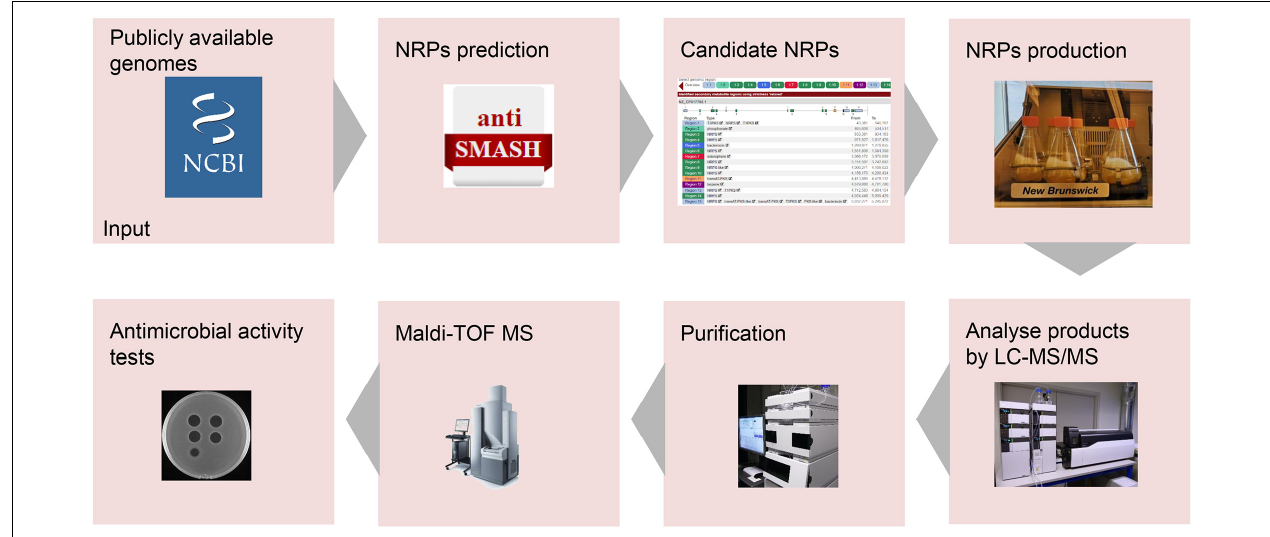
FIGURE 5 | Pipeline for the development of novel non-ribosomally produced peptide (NRP)-based antimicrobials. Following the arrows, the process starts with the identification of NRP clusters. Next, the predicted NRPs have to be produced, isolated, and characterized. Finally, the antimicrobial activity of the purified NRPs will be